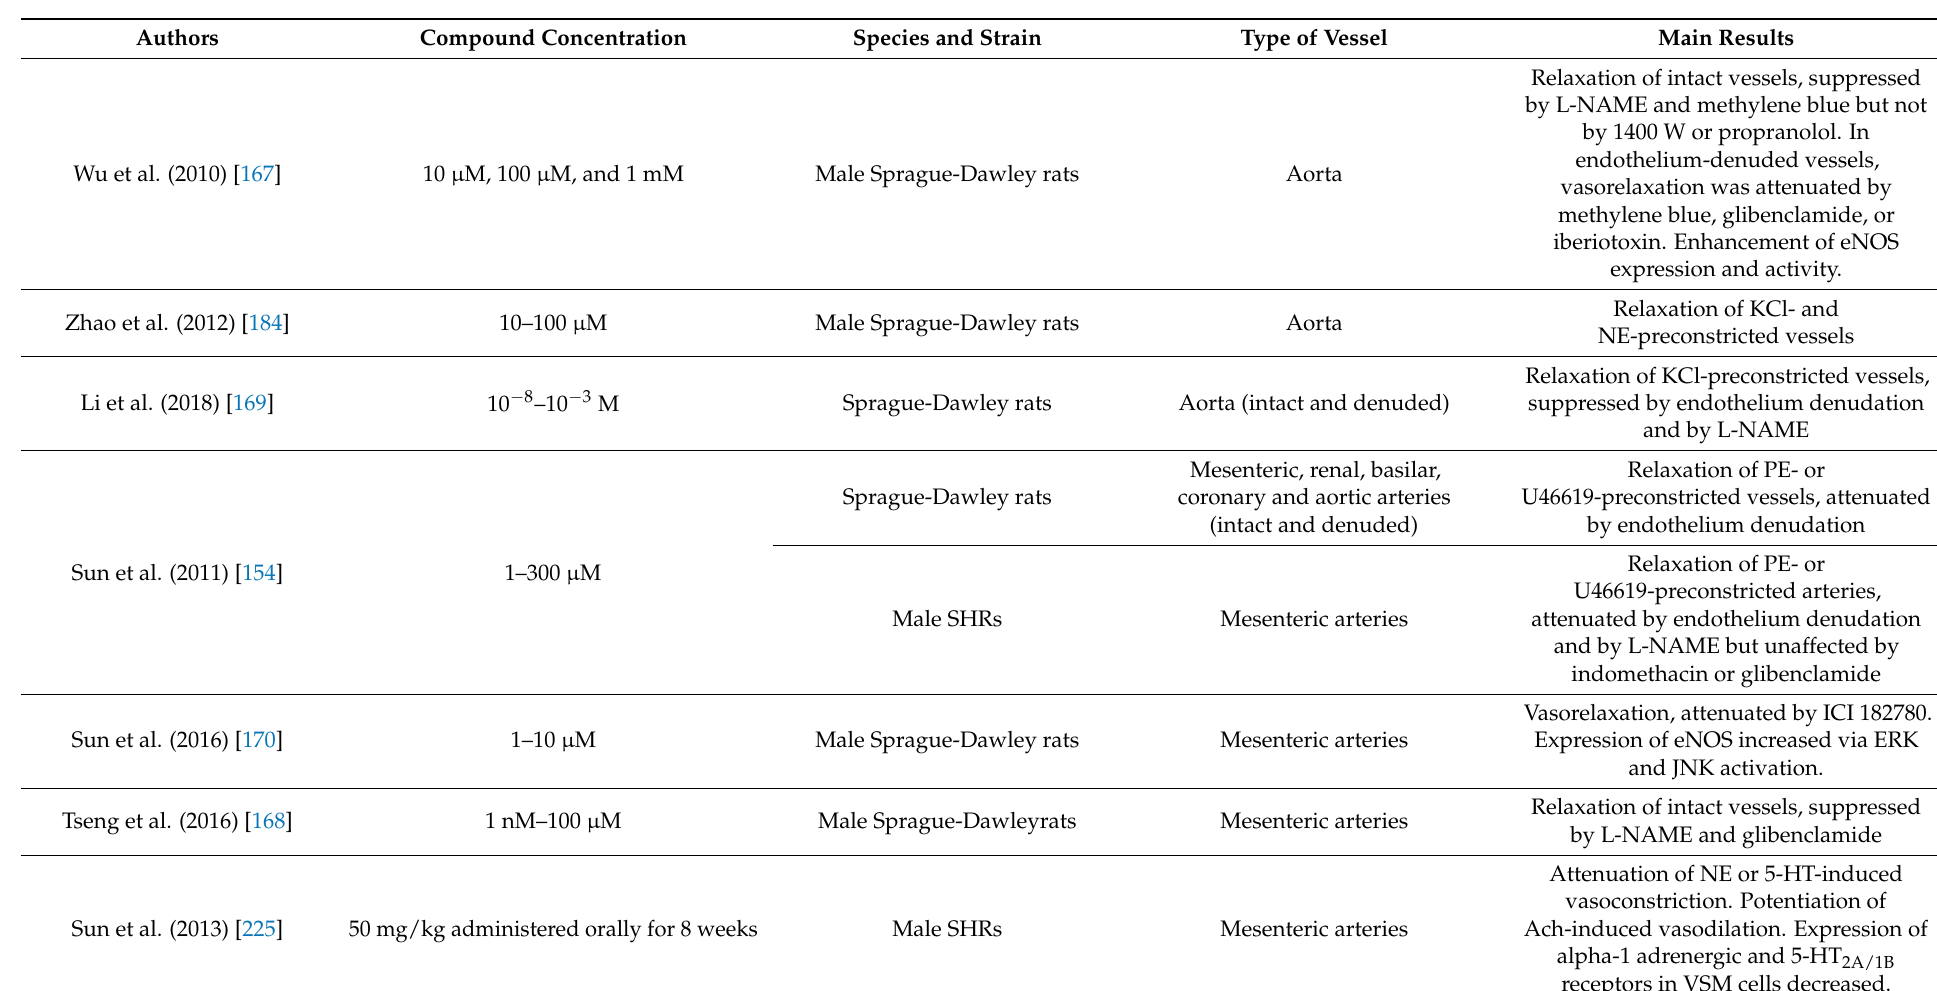
Table 4. Description and main results of in vitro studies on the vasorelaxant activity of